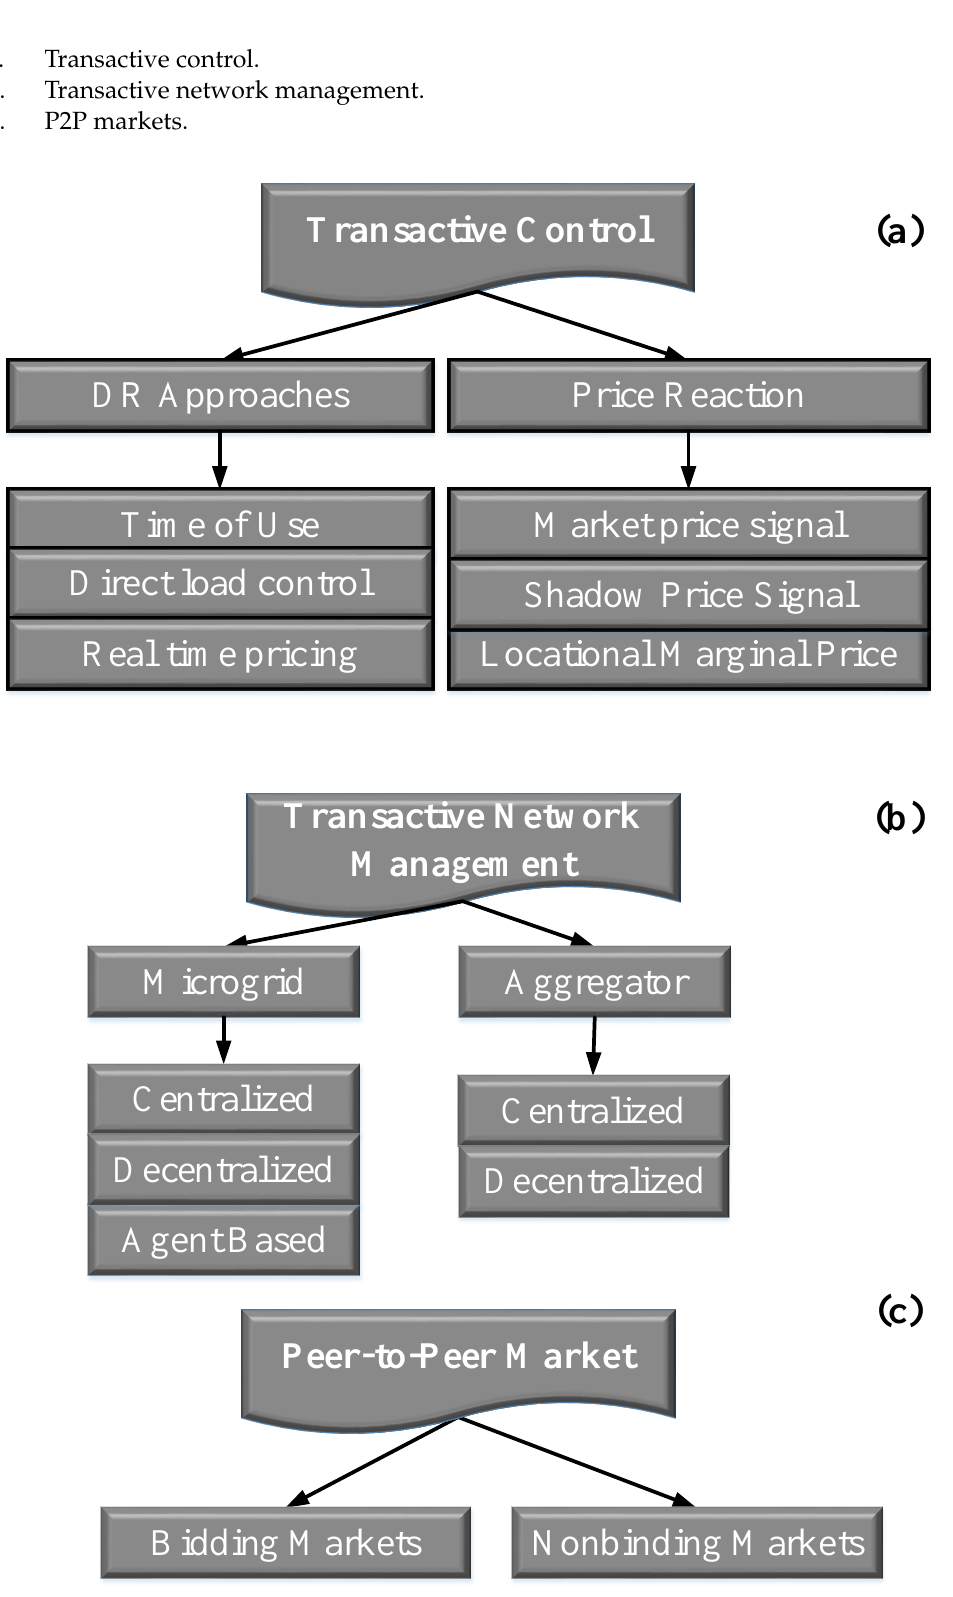
Figure 6. ( a ) TE-related concepts in control ( b ) TE-related concepts in management ( c ) TE-related concepts in P2P market